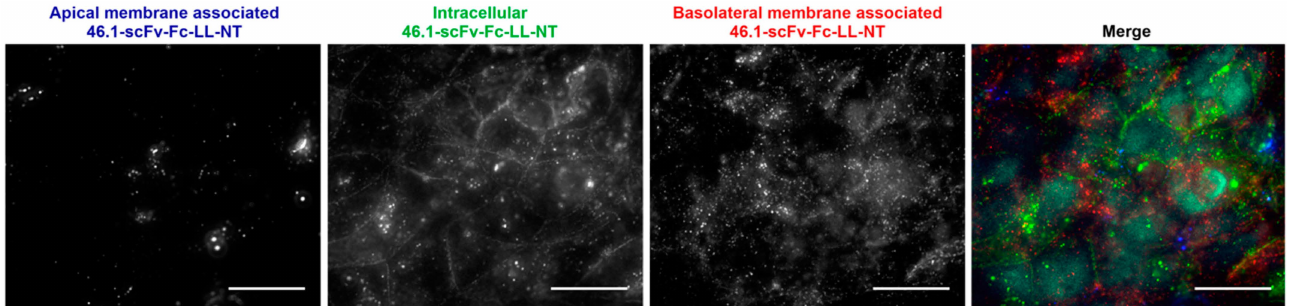
Figure A2. Basolateral to apical transport of 46.1-scFv-Fc-LL-NT. Confluent, barrier forming, iPSC BMEC-like cells on Transwell filters were incubated for 45 min at 37 ◦ C with 5 µ g/mL antibody 46.1-scFv-Fc-LL-NT, added to the basolateral compartment. Live cells were post-labeled on ice with secondary anti-rabbit AlexaFluor647 (blue) in the apical compartment, and AlexaFlour555 (red) in the basolateral compartment. Both compartments were washed, BMEC-like cells fixed, permeabilized, and incubated with secondary anti-rabbit AlexaFluor488 (green) to visualize the internalized antibody. All three secondary antibodies had distinctive appearances that were not spatially overlapping, indicating the lack of the paracellular diffusion of 46.1-scFv-Fc-LL-NT or any of the secondary antibodies. Of note, the intracellular fraction of 46.1-scFv-Fc-LL-NT was found at the cell–cell contacts as we have previously documented for apical to basolateral transport [9]. Scale bar, 20 µ m.